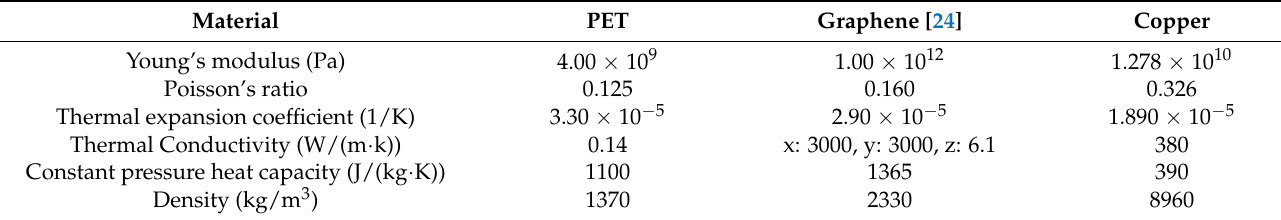
Table 1. Material properties used in this study.